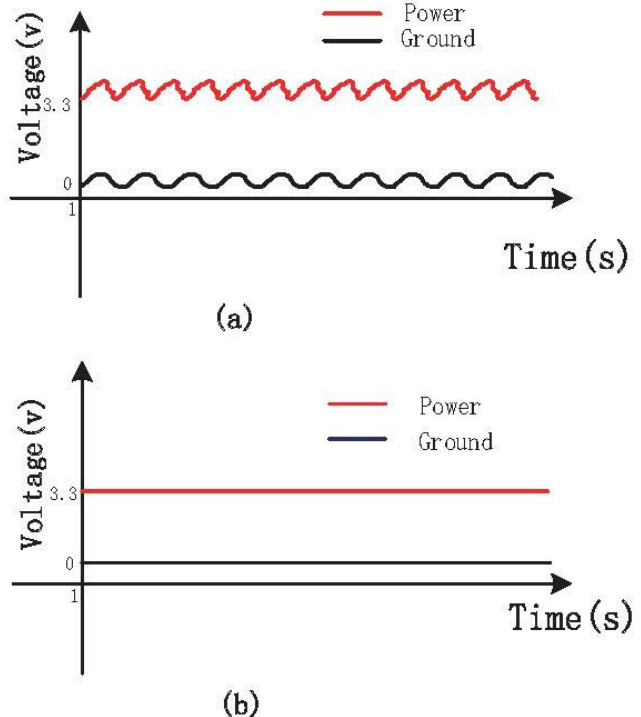
Figure 10. ( a ) Power and ground signals before isolating; ( b ) Power and ground signals after isolating.